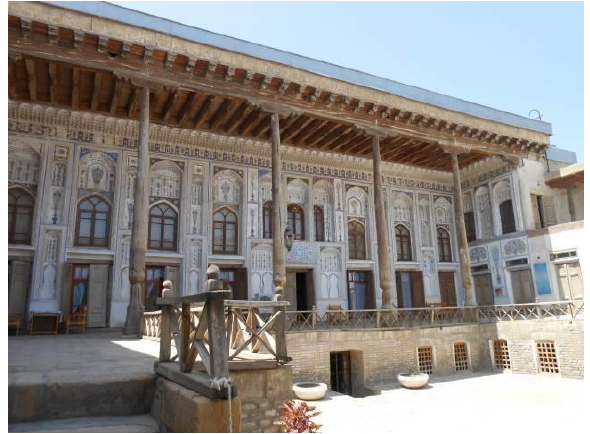
Figure 1. The Jewish House in Bukhara. Traditional Bukharian house with nim-ayvan. © UNESCO field survey project (2013)